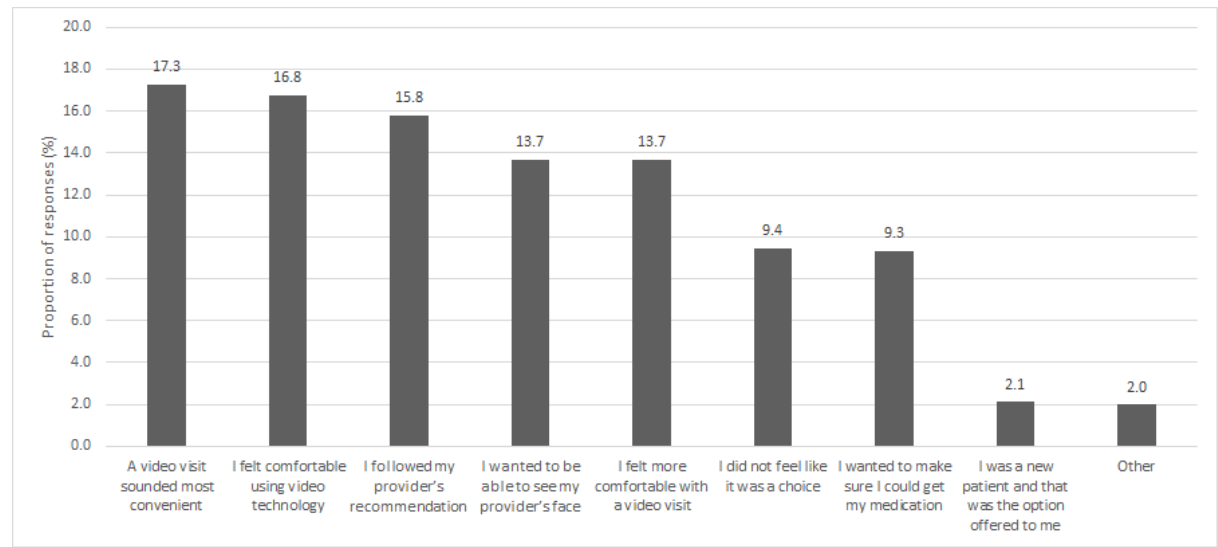
Figure 1. Factors influencing patients’decisions to receive care by video visit.